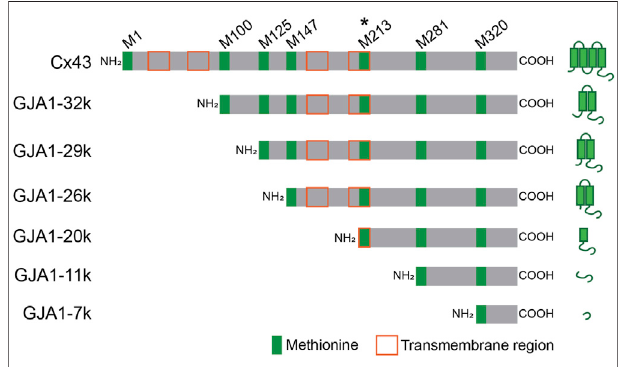
FIGURE 1 | Schematic Gja1 mRNA of full-length Cx43 and N-terminus truncated isoforms. GJA1-20k is translated from start codon at M213 and most abundant isoform. Green and orange squares indicate methionine on Gja1 mRNA and transmembrane region after translation,